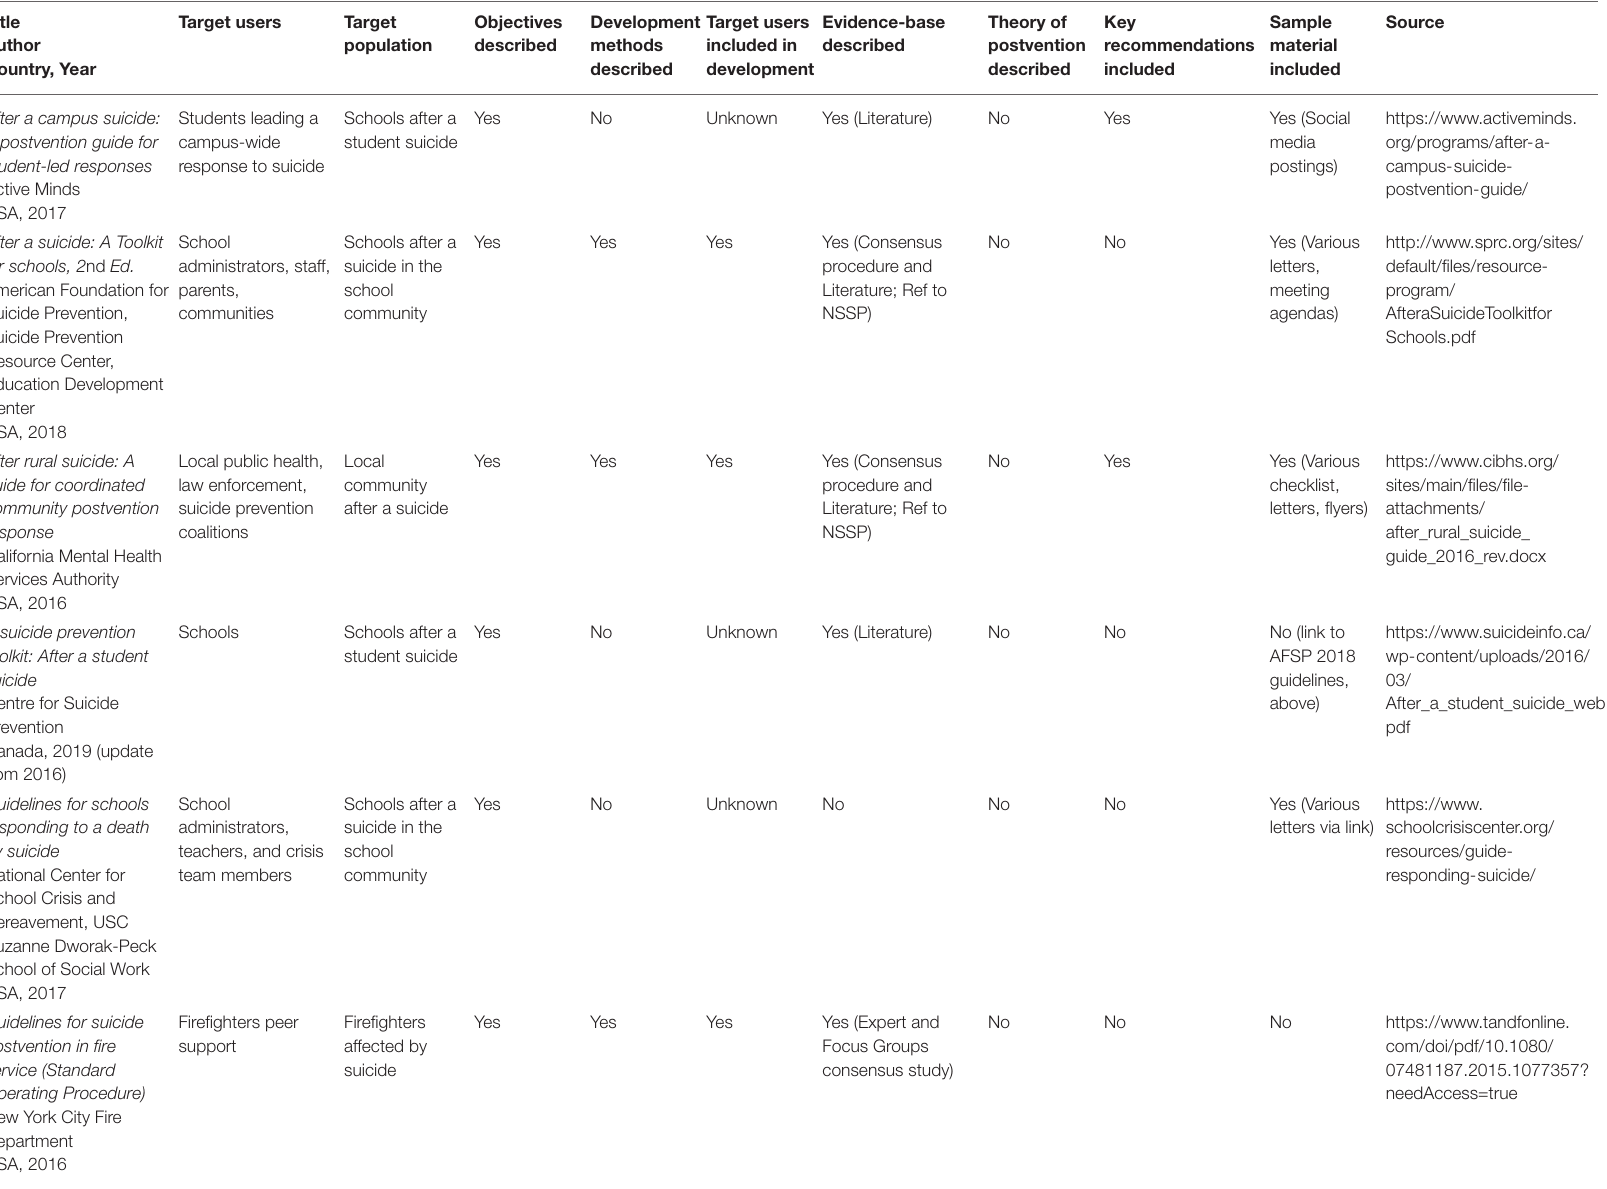
TABLE 5 | Summary of guidelines a ( n =